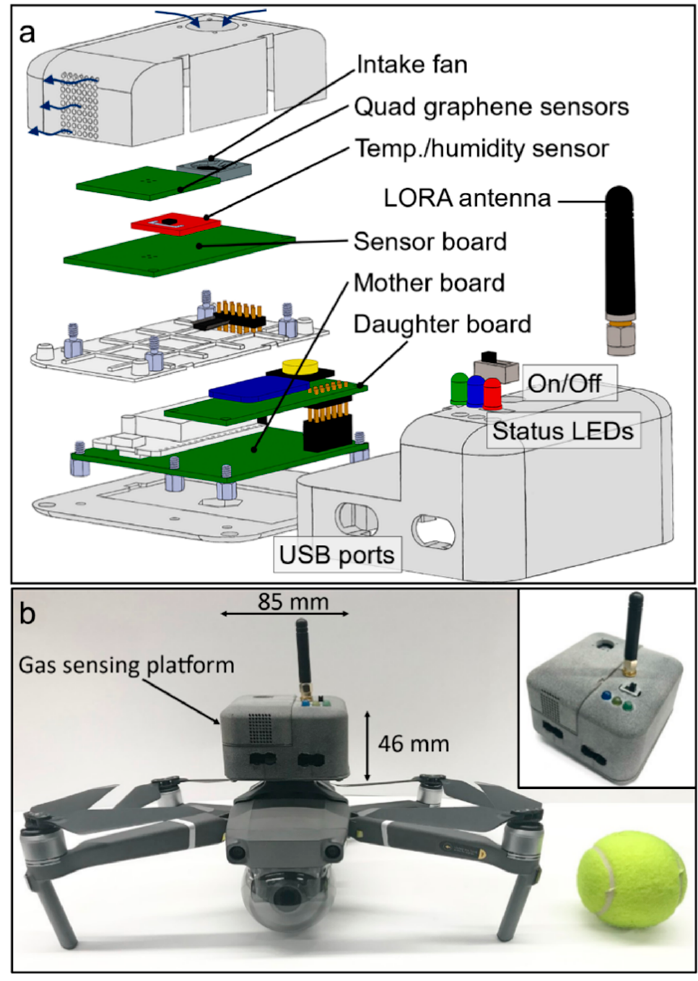
Figure 2. ( a ) Schematic of the gas sensing platform showing components and configuration. ( b ) Photo of the gas sensing device mounted on top of a drone, and unmounted in inset, with dimensions comparable to a tennis ball.